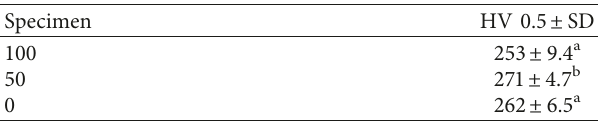
The mean values with dissimilar indices are significantly different at P < 0 . 05. The letters a and b indicate the existence of significant differences between the mean values of hardness.